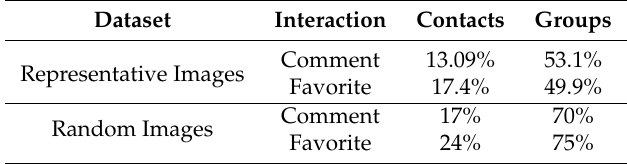
Table 2. Percentage of explicit social interactions with images from groups and user